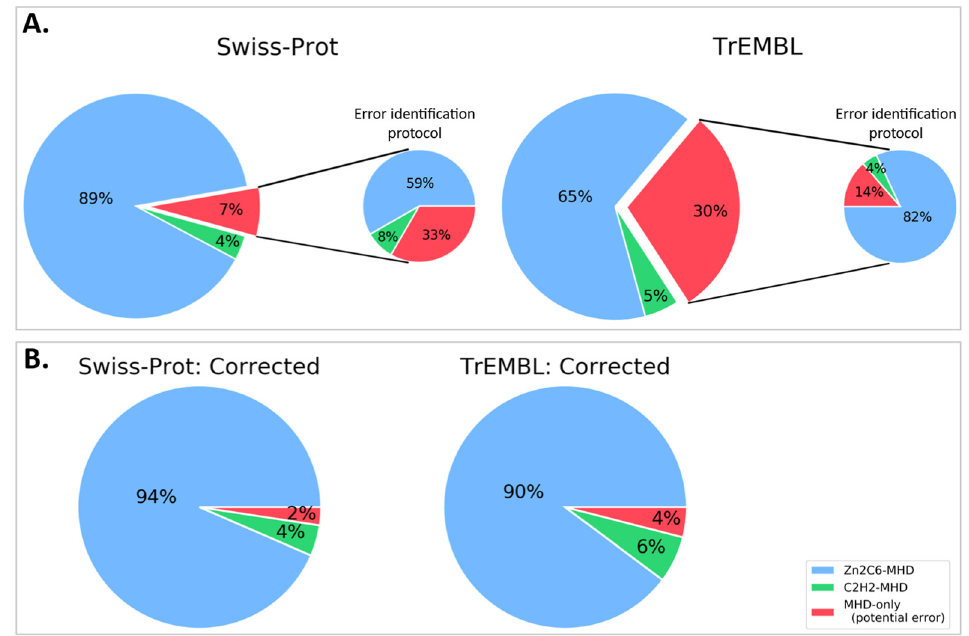
Figure 6. Proportion of sequences with Zn2C6–MHD (blue) or C2H2–MHD (green) domain combi- nations in ( A ). public databases: Swiss-Prot and TrEMBL (sequences mapped to ENSEMBL only) and ( B ). after applying our error identification protocol. The proportion of potentially erroneous sequences lacking a DBD is shown in red.